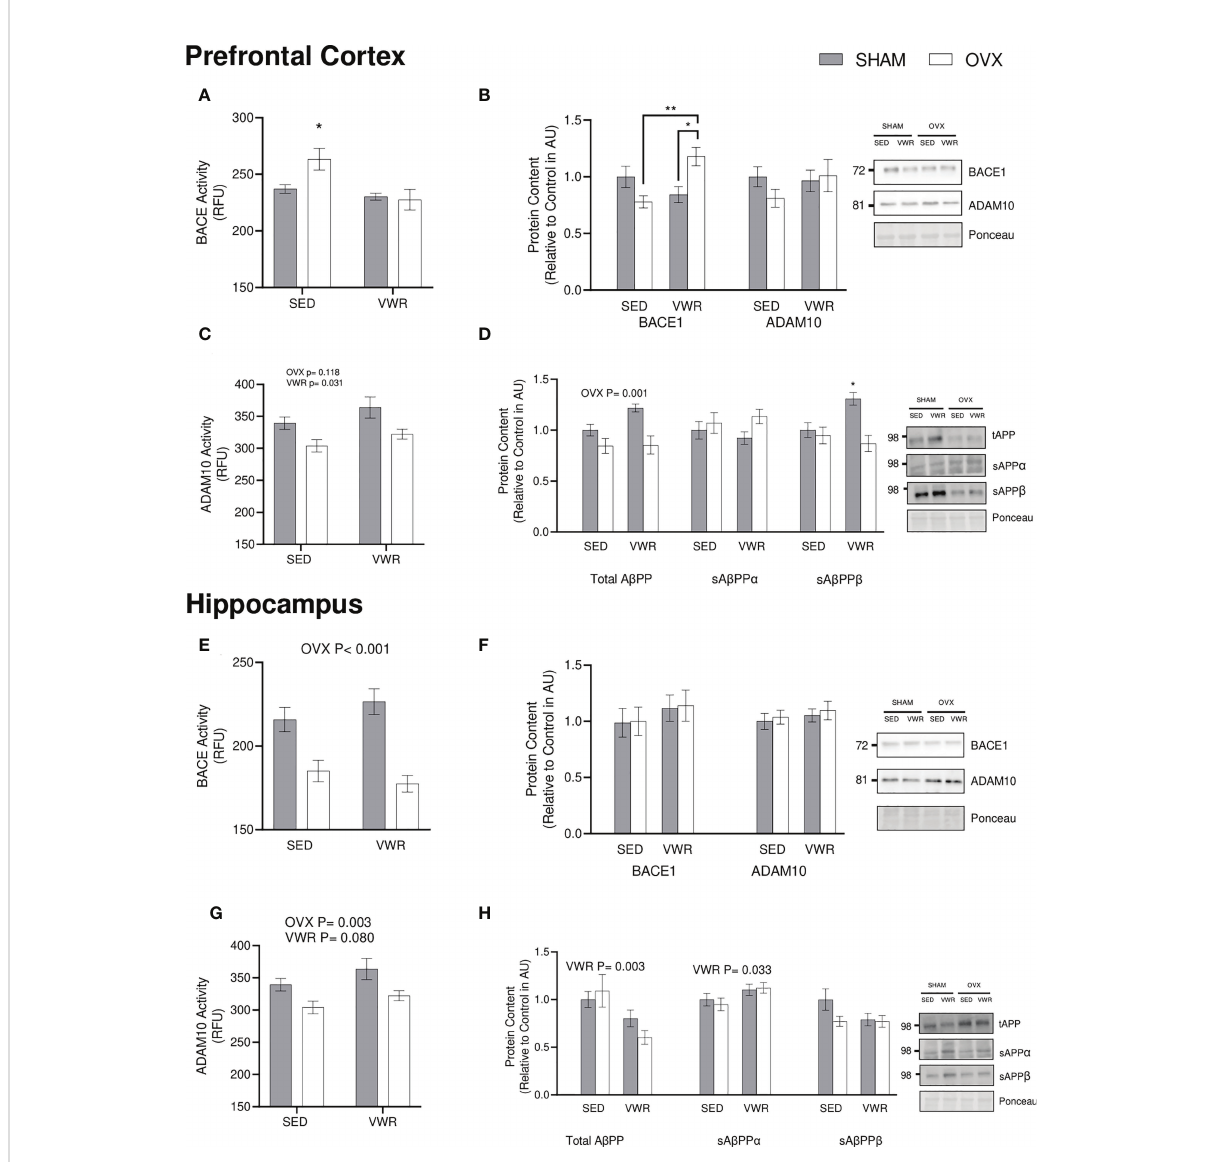
FIGURE 3 ABPP processing. (A) Prefrontal cortex BACE1 endpoint activity (RFU/µg total protein). (B) Prefrontal cortex BACE1 and ADAM10 content (AU). (C) Prefrontal cortex ADAM10 endpoint activity (RFU/µg total protein). (D) Prefrontal cortex total A b PP, sA b PP a , sABPP b content and sA b PP a / sA b PP b ratio (AU). (E) Hippocampus BACE1 endpoint activity (RFU/µg total protein). (F) Hippocampus BACE1 and ADAM10 content (AU). (G) Hippocampus ADAM10 endpoint activity (RFU/µg total protein). (H) Hippocampus total ABPP, sA b PP a , sA b PP b content and sA b PP a /Sa b PP b ratio (AU). All graphs are accompanied by representative blots. All data analyzed using a two-way ANOVA. ABPP, amyloid precursor protein; SA b PP a , soluble amyloid precursor protein alpha; sA b PP b , soluble amyloid precursor protein beta; BACE1, beta-site ABPP cleaving enzyme 1; ADAM10, A disintegrin and metalloproteinase 1; RFU, relative fl uorescent units; AU, arbitrary units; SED, sedentary; VWR, voluntary wheel running; OVX, ovariectomized; SHAM, sham operated. Signi fi cance is set to *P ≤ 0.05; **P ≤ 0.005; P ≤ 0.05; n=10 per